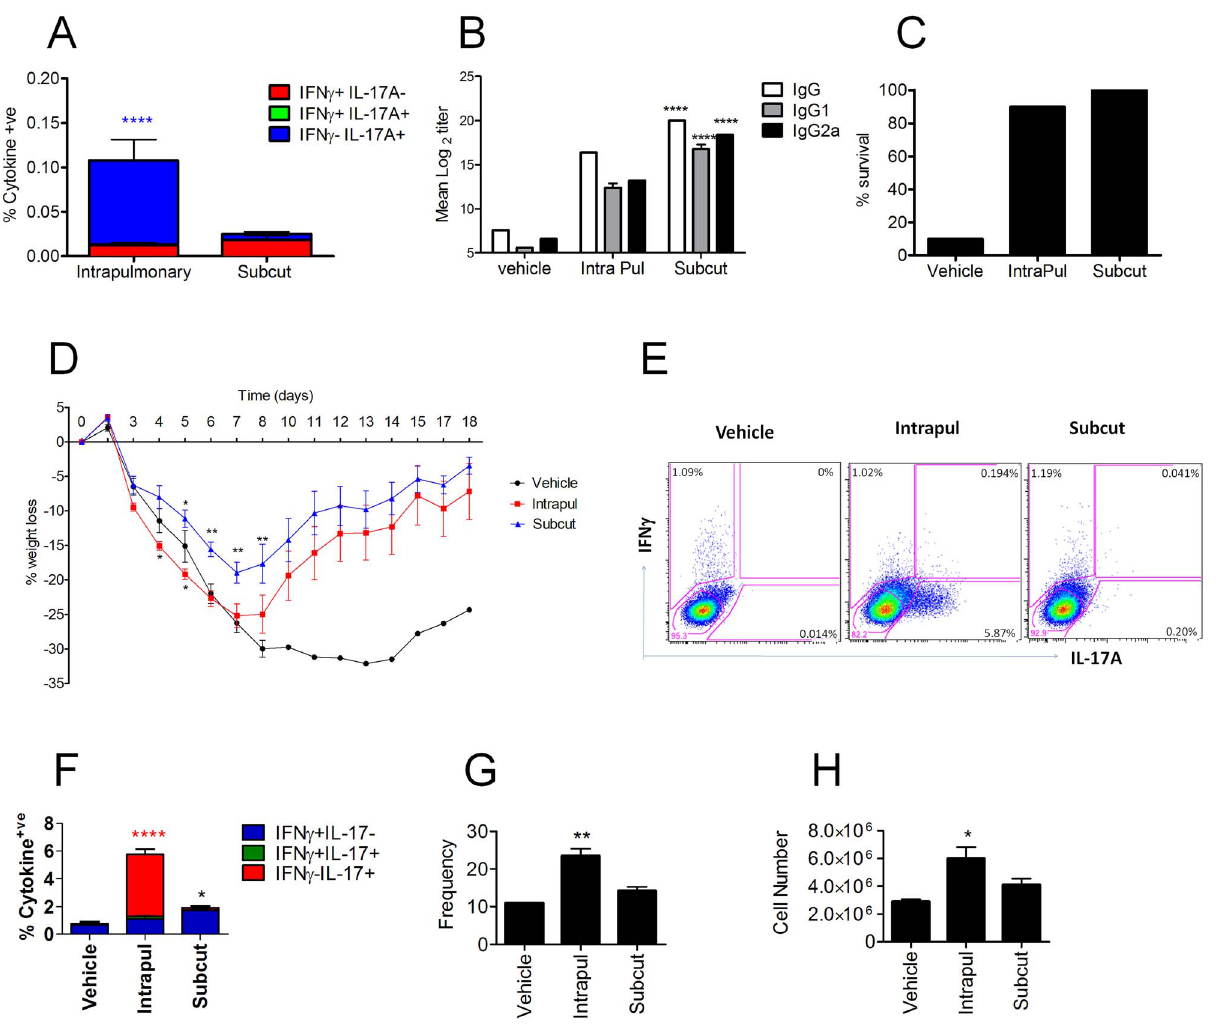
Figure 4. Enhanced vaccine efficacy following subcutaneous immunization. Balb/c mice were vaccinated with CRX-601 liposome (1 m g/ mouse) and split influenza virus antigen (A/Uruguay/716/2007 (H3N2)) either via an intranasal (intrapul) or subcutaneous (subcut) route. Splenic T cell responses (A) and serum influenza-specific IgG titers (B) were both examined 5 days post boost vaccination. Percentage survival (C) and percentage weight change (D) following challenge with a lethal dose of A/Hong Kong/1968 (H3N2) influenza virus. Lung influenza specific CD4 + T cells responses were evaluated at 5 days post challenge (E, F), in addition to changes in frequency (G) and cell number (H) of Lung Gr-1 hi neutrophils. Data from 5 days post boost are means 6 SEM for 3 (T-cell) or 8 (Antibody) replicates and is representative of two independent experiments. Data from 5 day post challenge are means 6 SEM for three replicates and is representative of two independent experiments. * p , 0.05, ** p , 0.01, ***p , 0.001, **** p , 0.0001 denote significance when compared to vehicle treated controls (Figure 4A,F (two-way ANOVA, Bonferroni post test), Figure 4B,C, D,G,H (One-way ANOVA Dunnet post-test)).